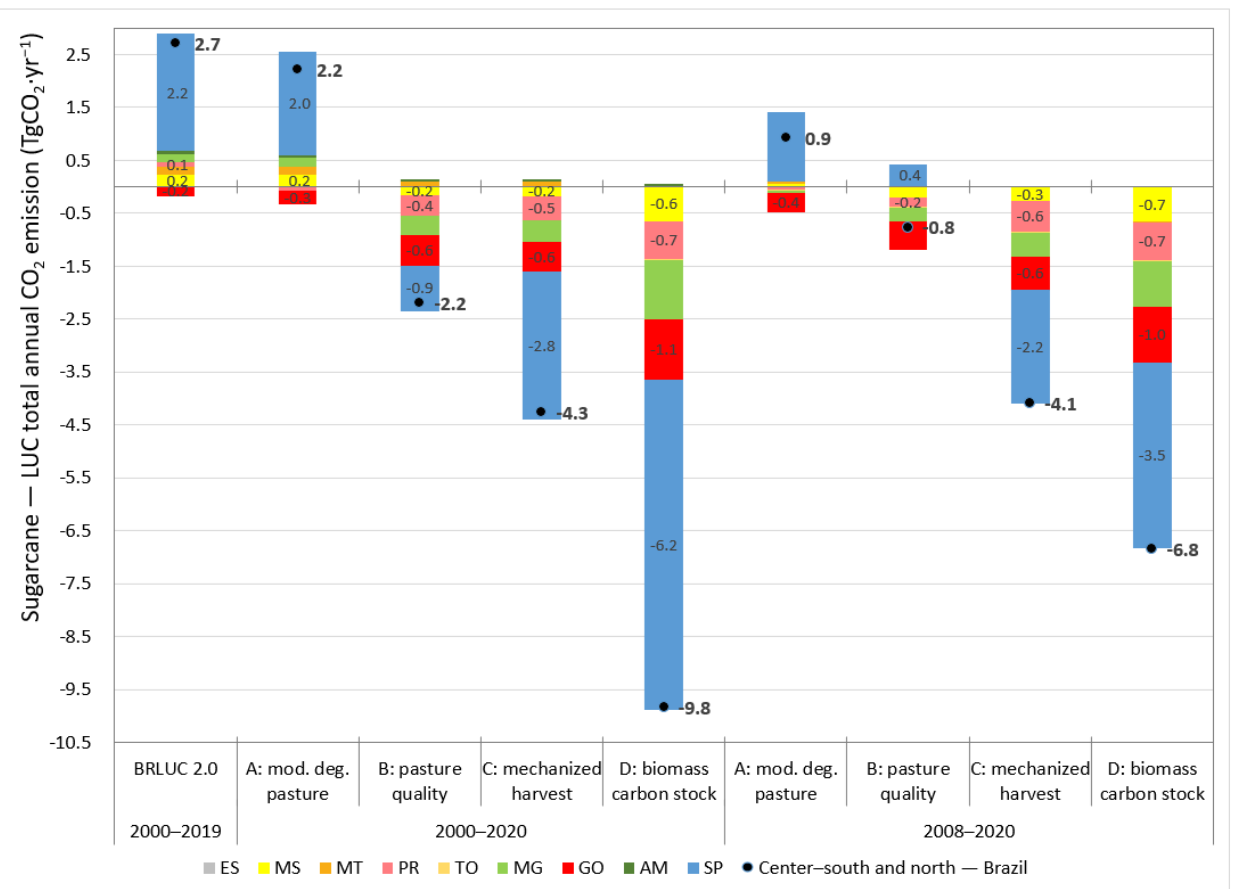
Figure 8. Estimated absolute annual CO 2 emissions from LUCs associated with sugarcane cultiva- tion estimated by each parametrization in the center–south and north regions of Brazil and in the analyzed states.